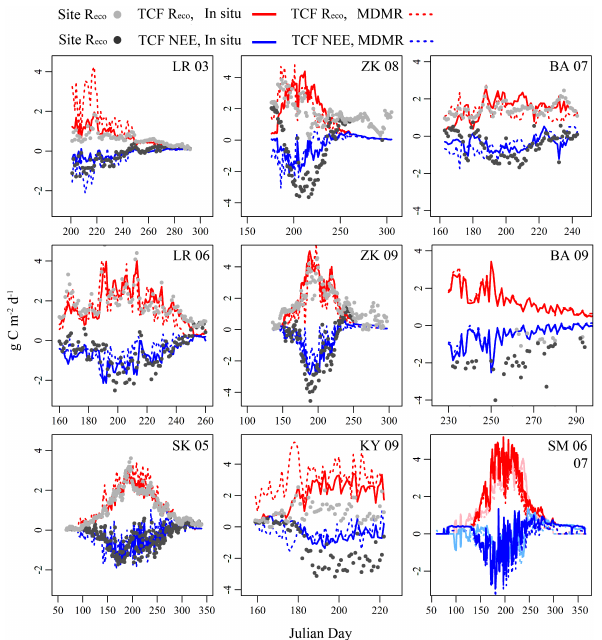
Fig. 4. TCF model CO 2 simulations driven using in situ (solid lines) or remote sensing and reanalysis inputs (MDMR; dashed lines), as compared with tower EC records (circles) for R eco and NEE. For BA 2009, in situ R eco was not available and NEE measurements from the northern (central) tower are shown in black (gray). The TCF model R eco results for SM 2006 (2007) are displayed in light (dark) red and NEE is indicated in light (dark) blue.